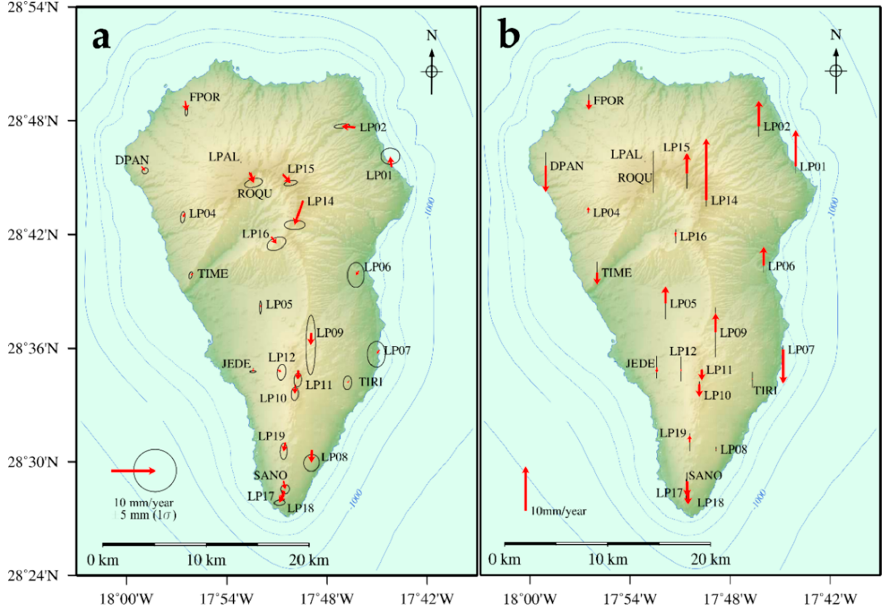
Figure 3. Annual mean velocities for the GNSS monitoring stations on La Palma Island with their uncertainties for the period 2006–2011: ( a ) horizontal annual mean velocities; and ( b ) vertical annual mean velocities.